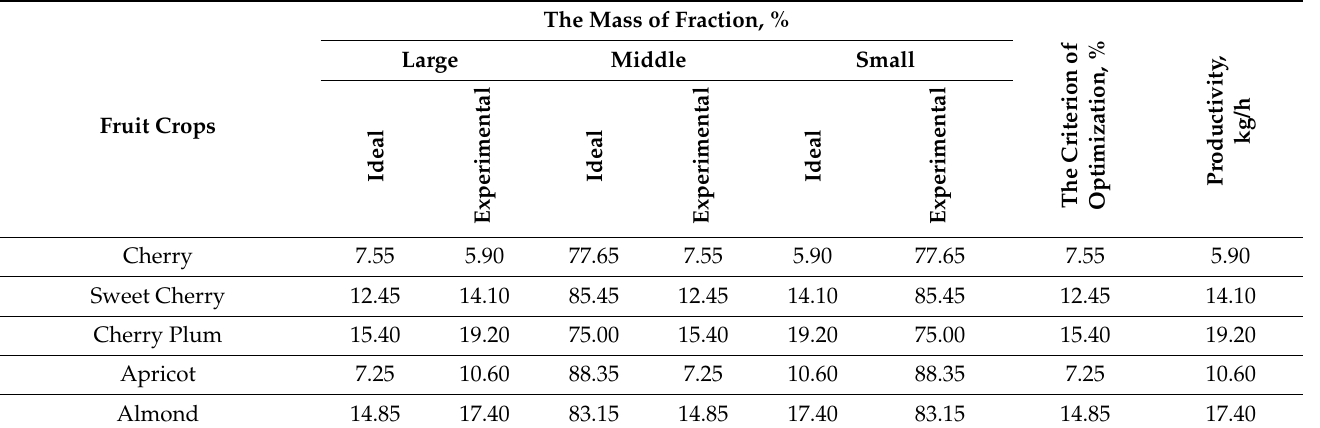
Table 6. Fractional composition of seeds as a percentage of the mass and productivity of the unit for calibration of fruit culture